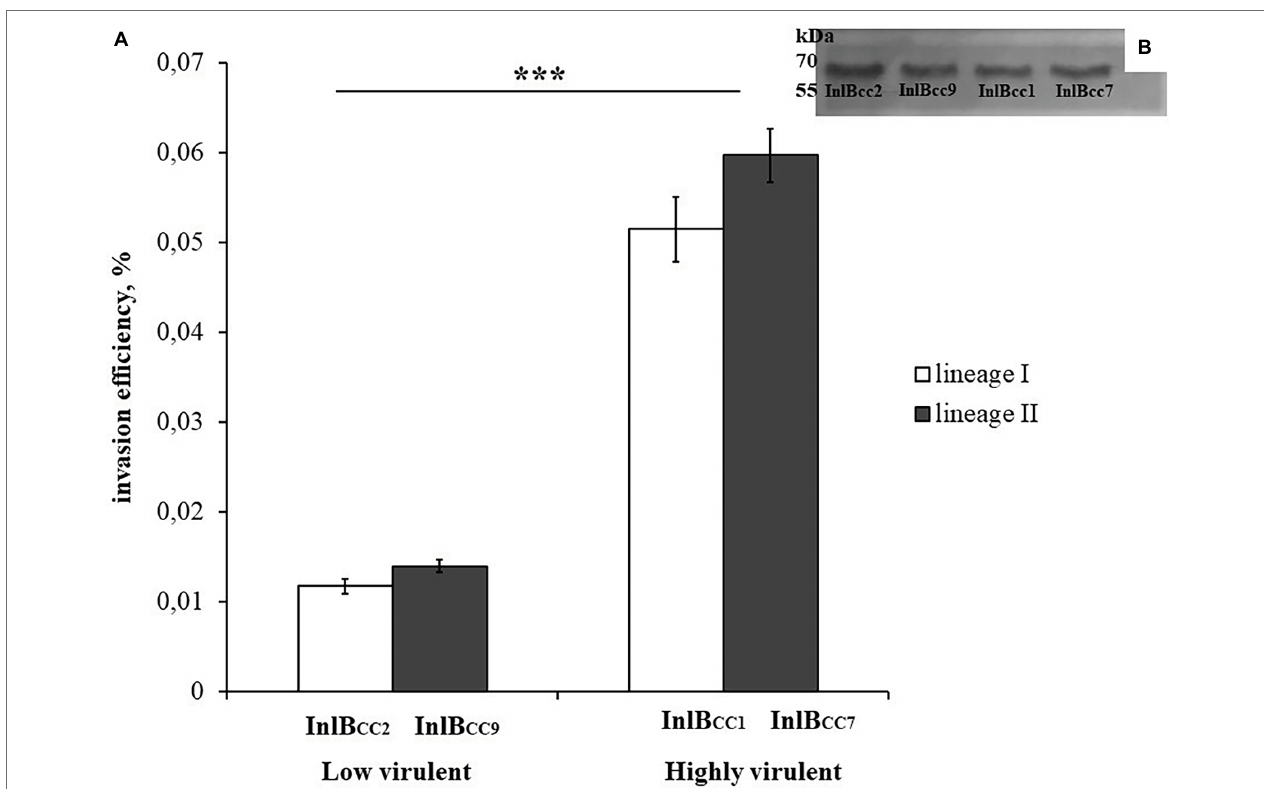
FIGURE 9 | The level of invasion of Listeria monocytogenes into eukaryotic cells depends on the allelic variant of inlB. The recombinant strains differed only in the natural variant of internalin B. (A) Strains expressing natural variants of inlB characteristic of clonal complexes with low virulence reliably showed a level of invasion three times lower than the level of invasion shown by strains expressing natural variants characteristic of hypervirulent clonal complexes. The mean ± SD from three independent experiments is shown. The statistical significance of competition experiments relative to a corresponding positive control is shown (*** p < 0.001). (B) Immunoblotting analysis of membrane-bound proteins of recombinant strains encoding InlB variants. InlB was visualized with polyclonal primary anti-InlB antibodies were obtained as described earlier (Povolyaeva et al., 2020). GAPDH of L. monocytogenes was used as a